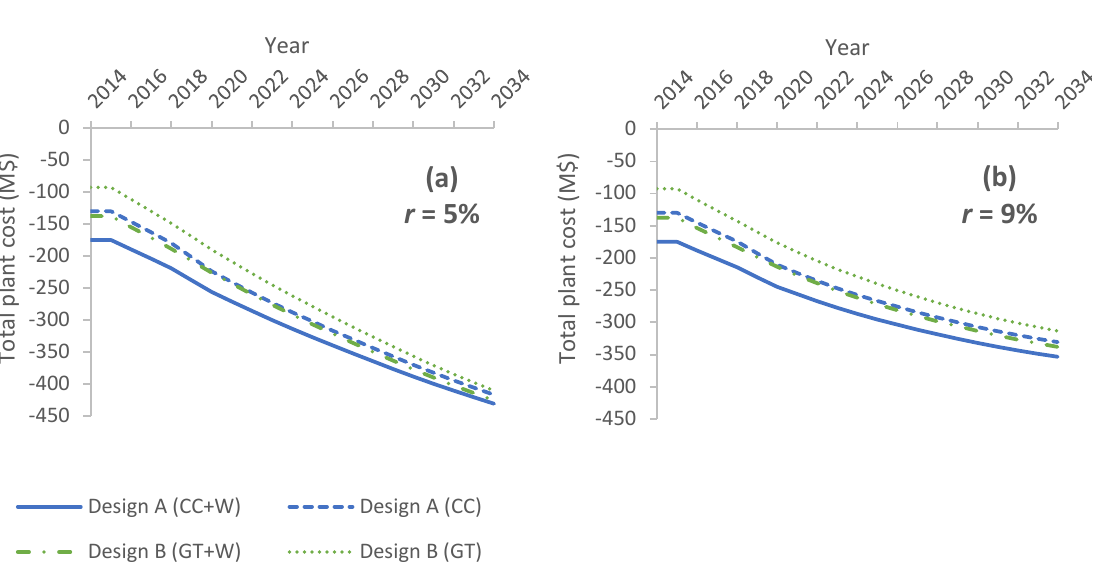
Figure 13. Evolution of the total plant cost throughout plant’s lifetime when the discount rate is set to ( a ) 5% or ( b ) 9%.